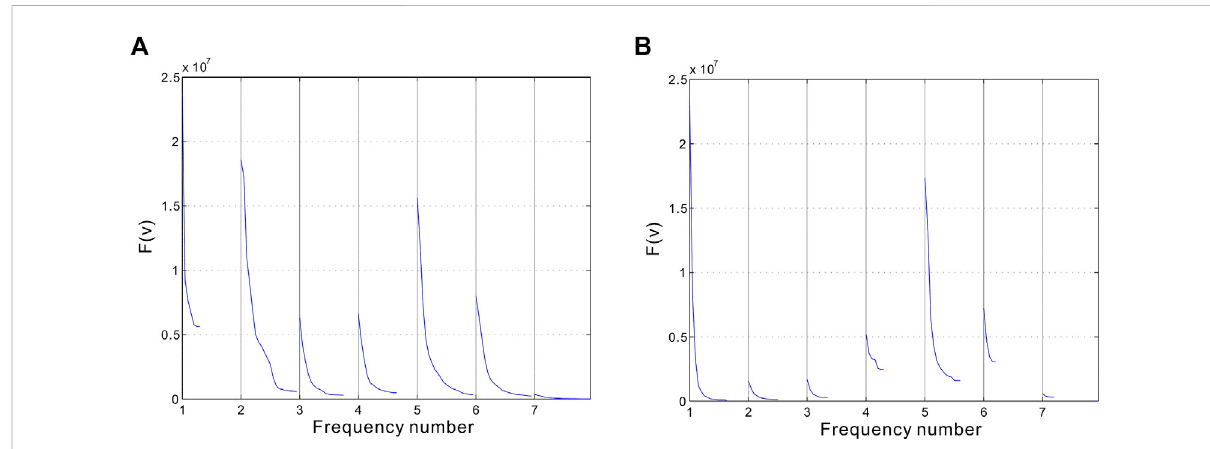
the horizontal axis denotes the 7 frequency numbers. The total iteration number of L-BFGS is 114, while the total iteration number of mL-BFGS is only 55. As shown in Table 1, the average calculation time for each iteration of the two methods is almost the same, but the mL-BFGS method converges